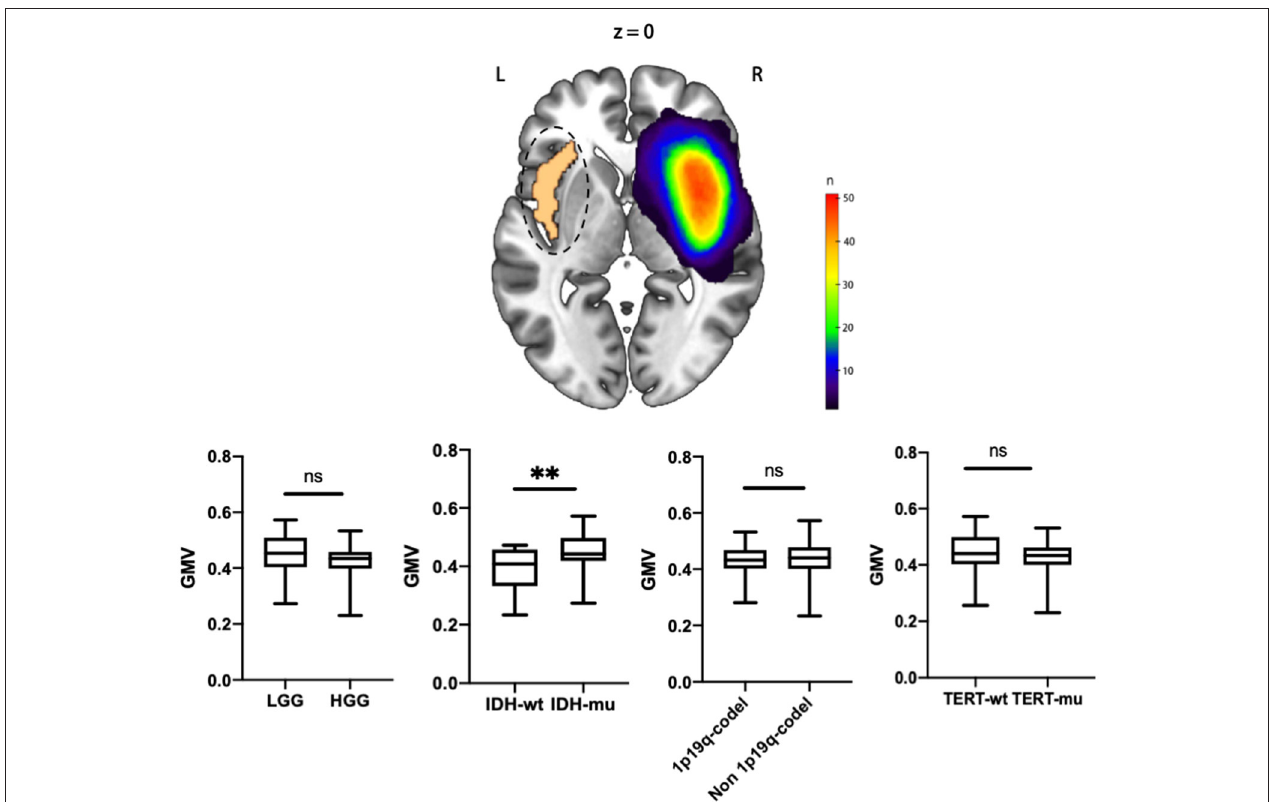
FIGURE 3 | The entire contralesional insula GMV comparisons between different histological grade and molecular pathology status. ** P < 0.01 ns, for not significant. TABLE 4 | t -test for GMV in different